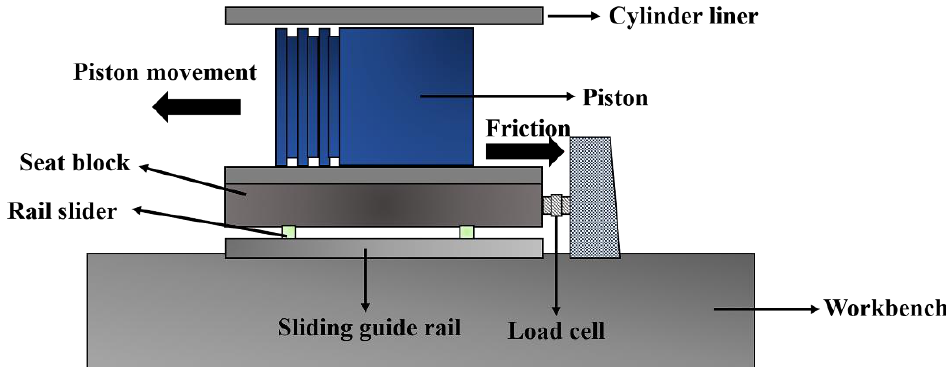
Figure 3. Schematic diagram of how to measure the friction force.